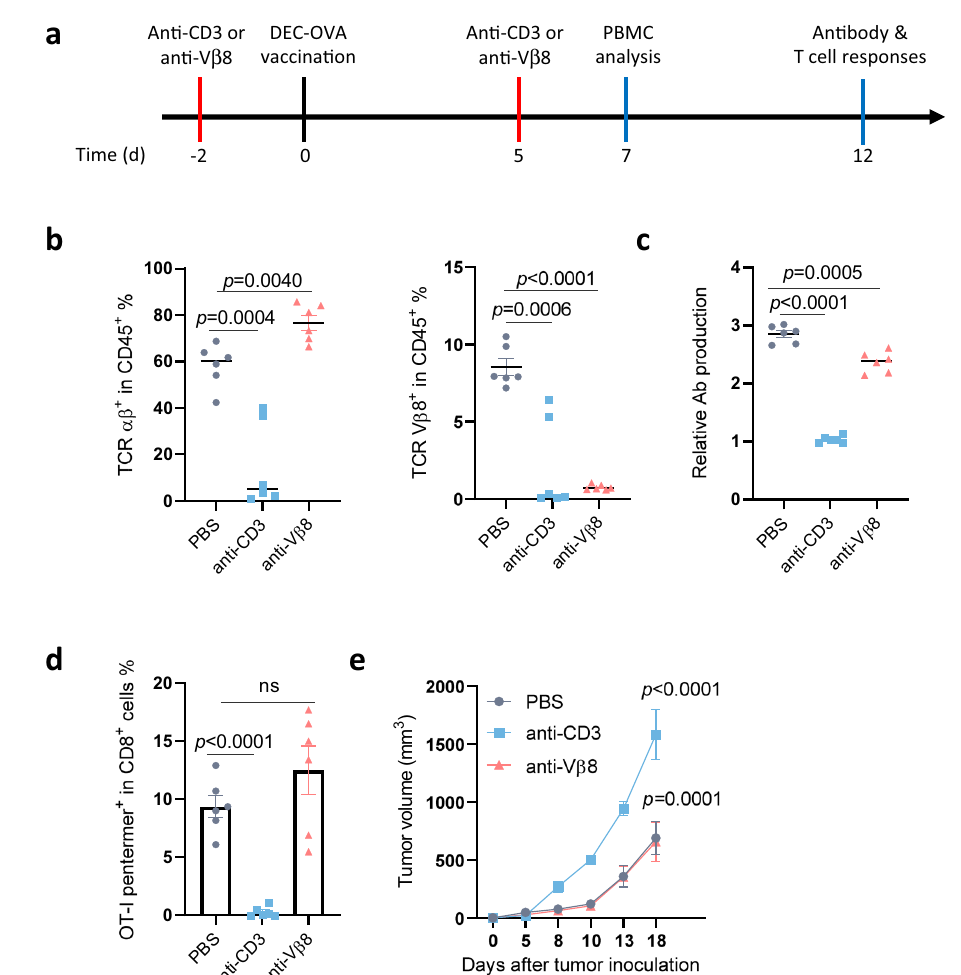
Fig. 6 | Suf fi cient T cell-mediated immunity after TCR V β 8 + cell depletion. a Schematic representation of the procedure used for analyzing cellular and humoral immune responses in V β 8 + cell-depleted mice. b – e Female WT B6 mice aged 6 – 8 weeks ( n =6 mice/group) were intraperitoneally injected with 200 μ g of anti-CD3 or anti-TCR V β 8 antibodies or PBS on days − 2 and 5. The mice were vaccinated with 10 µ g of the DEC-OVA fusion protein and 100 µ g of an anti-CD40 antibody as an adjuvant ( b – d ). On Day 7, peripheral blood TCR αβ + or V β 8 + cells wereanalyzedby fl owcytometry( b ).OnDay12, DEC-OVA-speci fi cantibodieswere analyzed by ELISA ( c ), and OT-I-speci fi c CD8 + T cell responses in the peripheral